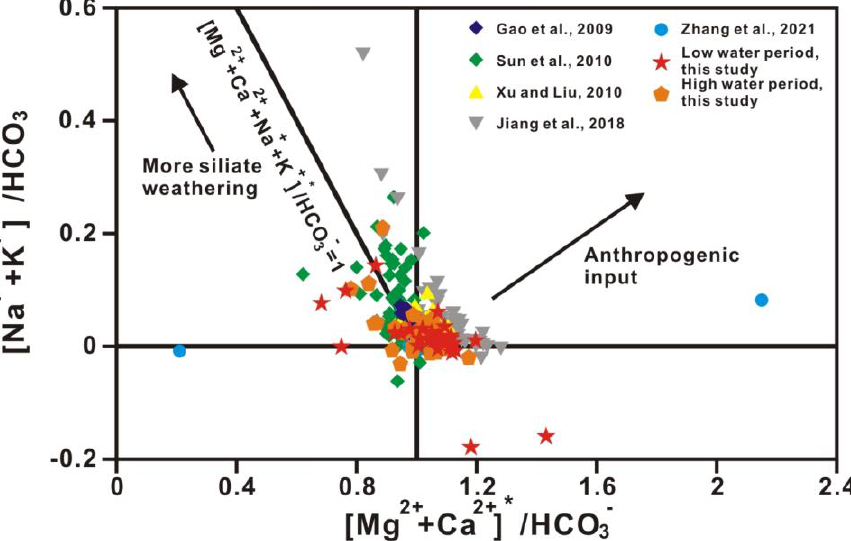
Figure 10. The ionic ratios of silicate and carbonate weathering in Xi River water. [Ca 2+ + Mg 2+ ] * was calculated by subtracting the SO 42 − equivalence from the total [Ca 2+ + Mg 2+ ] equivalence. [Na + + K + ] * was calculated by subtracting the Cl − equivalence from the total [Na + + K + ] equivalence. Refs. (Gao et al., 2009; Sun et al., 2010; Xu and Liu, 2010; Jiang et al., 2018; Zhang et al.; 2021) are cited in figure [2,10,20,22,28].